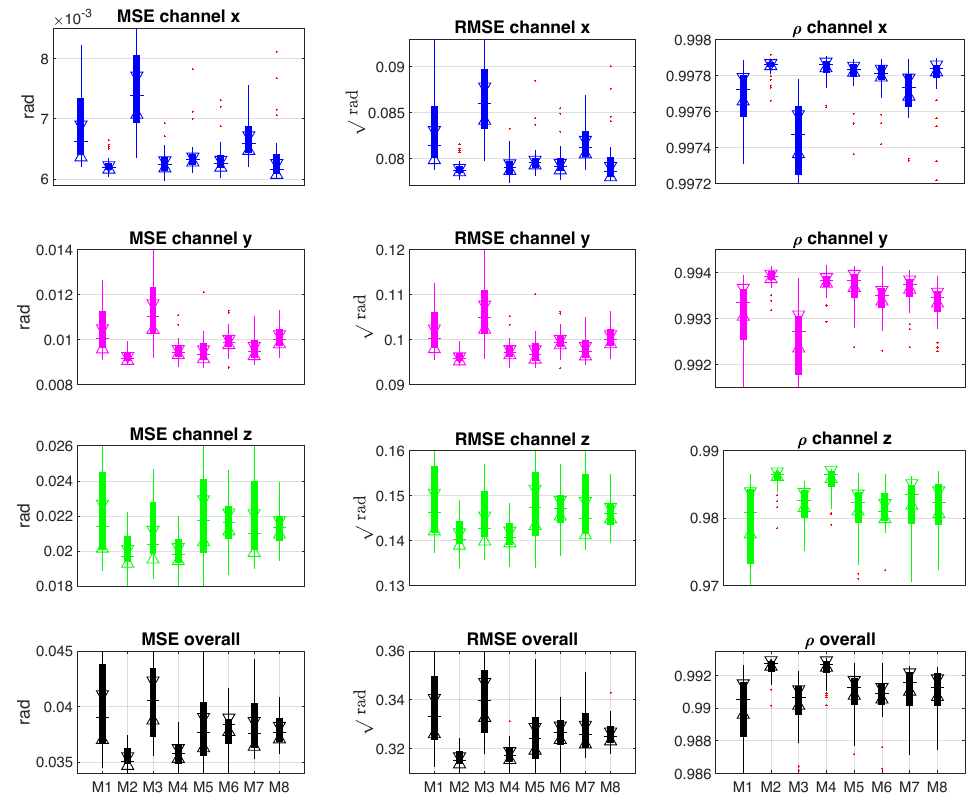
Figure 11. The comparison results of MSE, RMSE and correlation coefficient ρ among M1–M8 on the testing